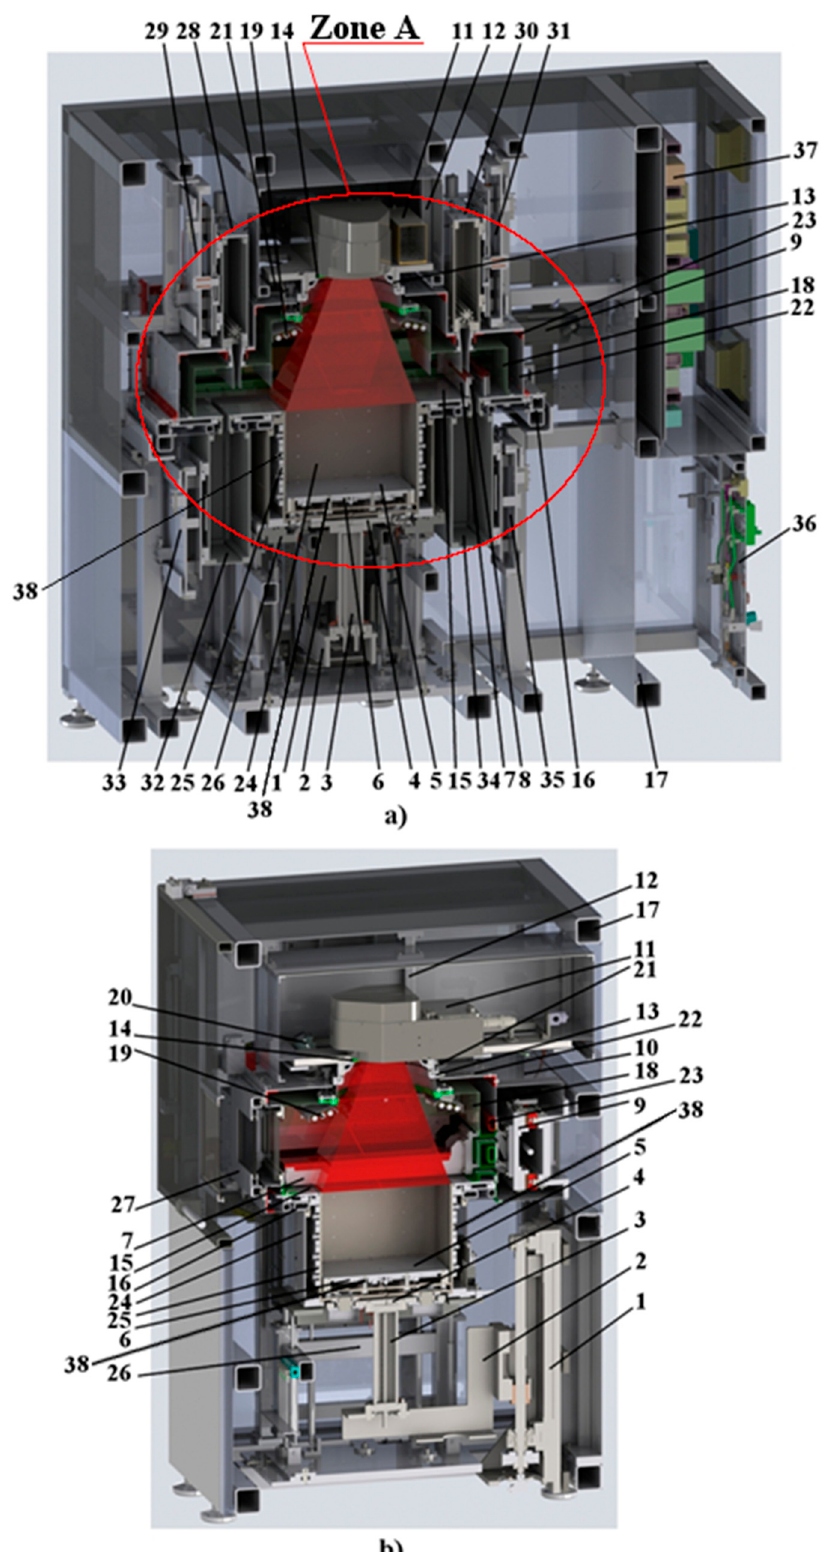
Figure 3. Structural plan (described in the text). Zone A is highlighted in further detail in below Figure 8: ( a )—longitudinal section, ( b )—cross-section.